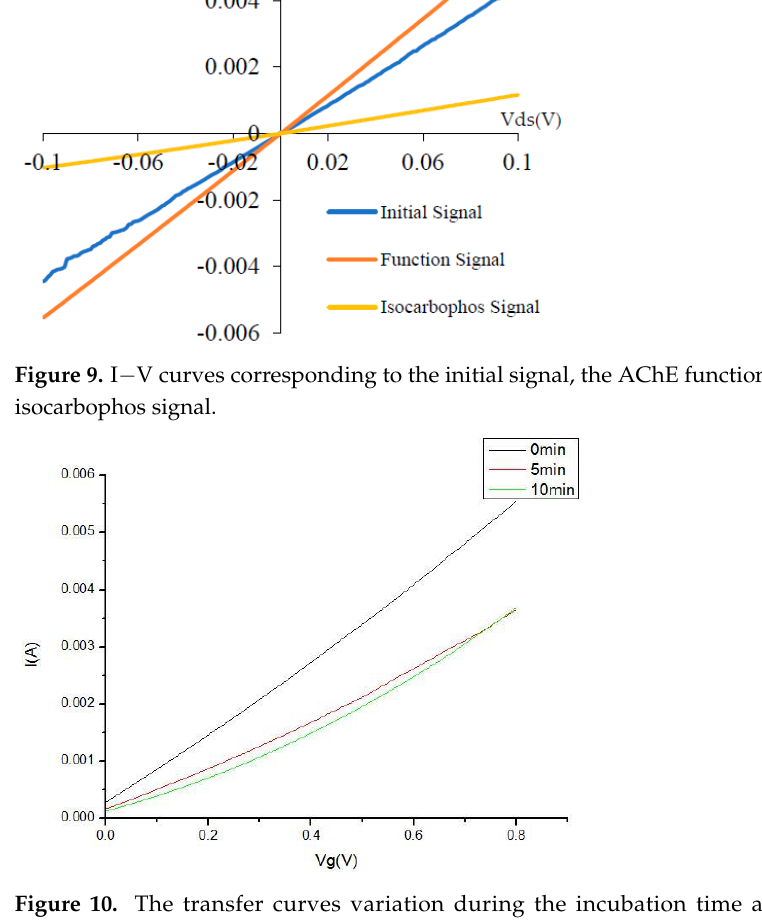
Figure 10. The transfer curves variation during the incubation time after adding our target organ- ophosphorus isocarbophos sample. organophosphorus isocarbophos sample.